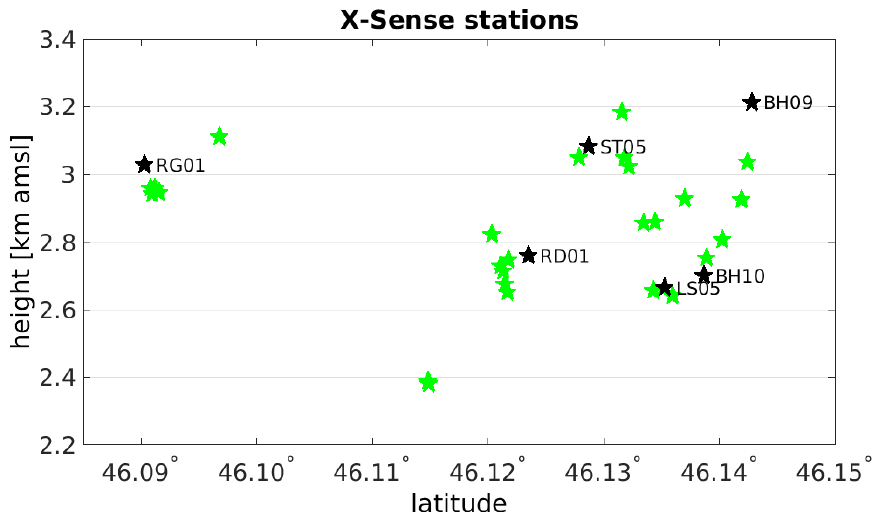
Figure 4. The green stars present the height distribution of the 32 X-Sense stations shown with respect to the latitude. The black stars indicate the 6 stations that are taken into ‘X-Sense 6’ data